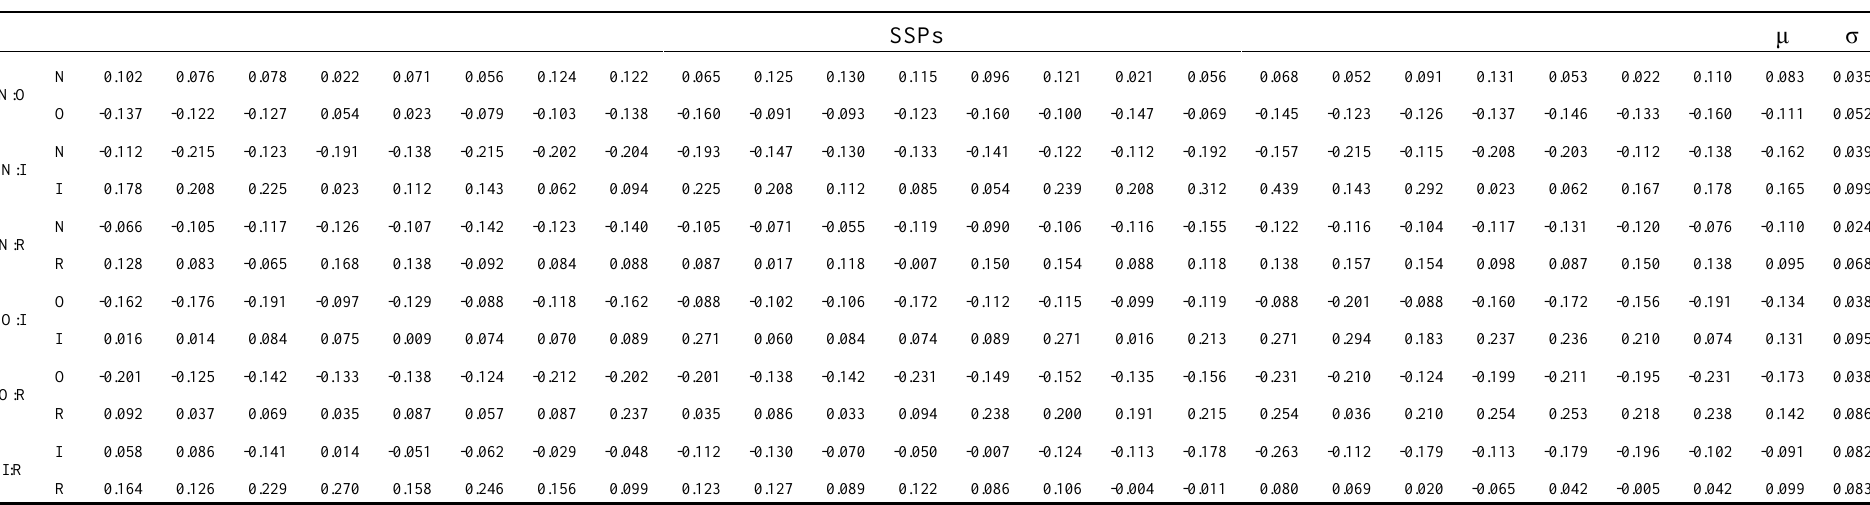
Table 5. Values of SSP for each sequential diagnosis